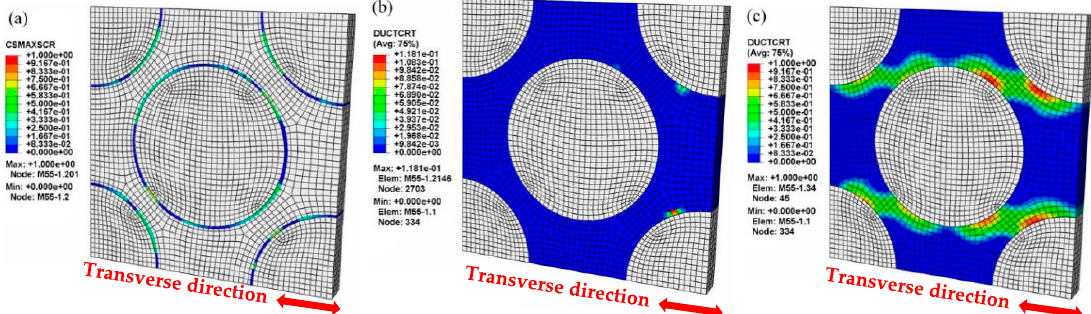
Figure 7. Microscopic damage and failure in the transverse tensile loading process in the MFEM-A model: ( a ) interface failure ( 𝜀 (cid:3021) = 0.07%); ( b ) matrix damage initiation ( 𝜀 (cid:3021) = 0.12%); ( c ) matrix failure ( 𝜀 (cid:3021) = 0.31%).